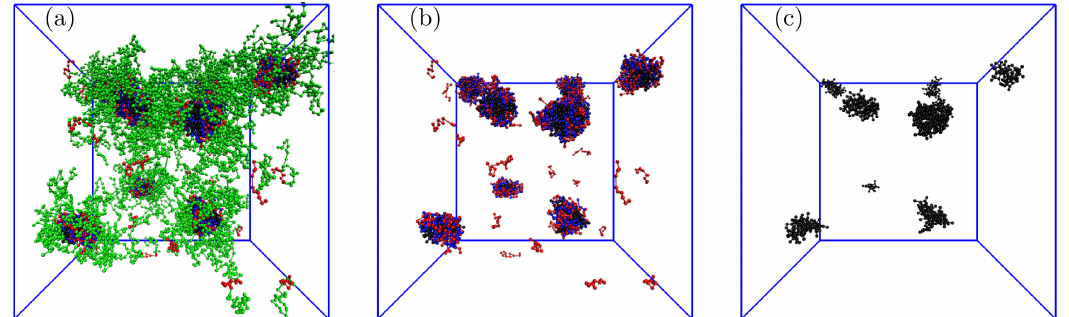
Figure 10. Typical snapshot of the simulation box for the system with 120 P + showing ( a ) whole associates, ( b ) IPEC cores with P + , and ( c ) P + only: the red and blue balls represent positively and negatively charged A blocks, respectively; the green balls are neutral B blocks, and the black balls are P +